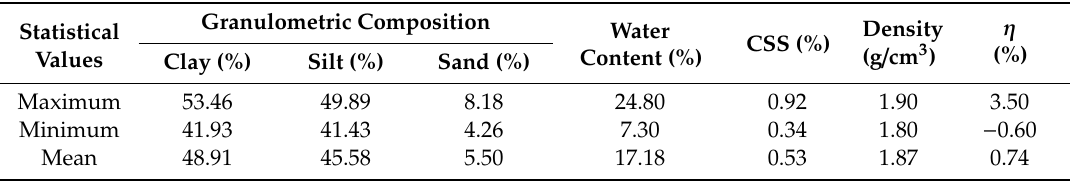
Table 6. Statistical values of soil parameters and experimental results [22].